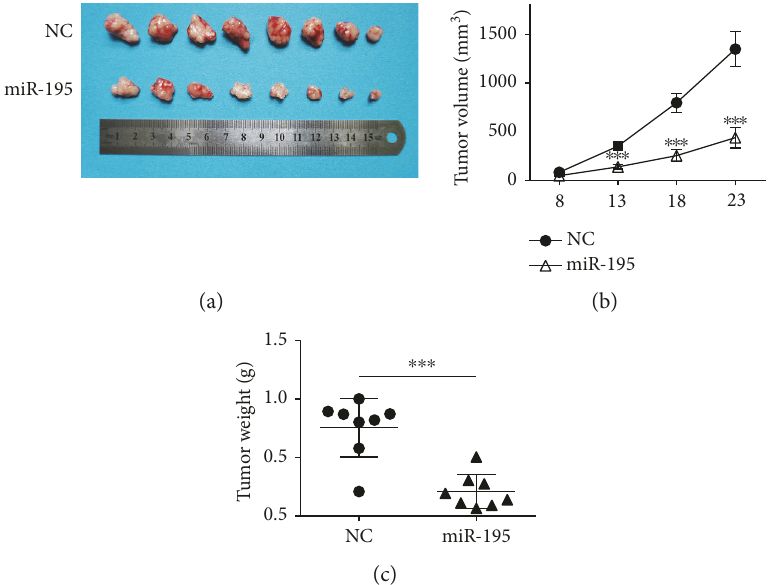
Figure 3: MiR-195 suppresses xenograft tumor growth of K1 cells in nude mice. (a) Tumors derived from NC or miR-195 overexpressing K1 cells were dissected from nude mice ( n = 8 ) at 23 days after subcutaneous injection. (b) Volume of tumors. (c) Weight of tumors. ∗∗∗ P < 0 001 compared with the NC